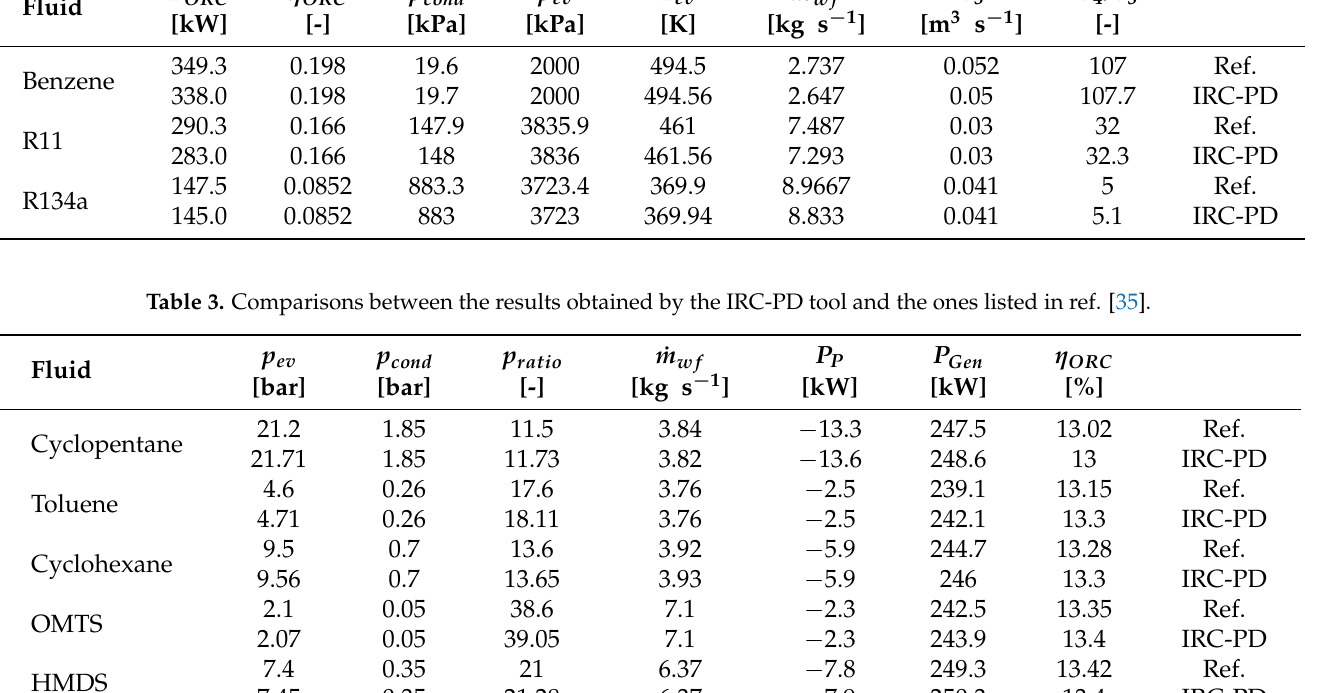
Table 2. Comparisons between the results obtained by the IRC-PD tool and the ones listed in ref. [59]. Fluid